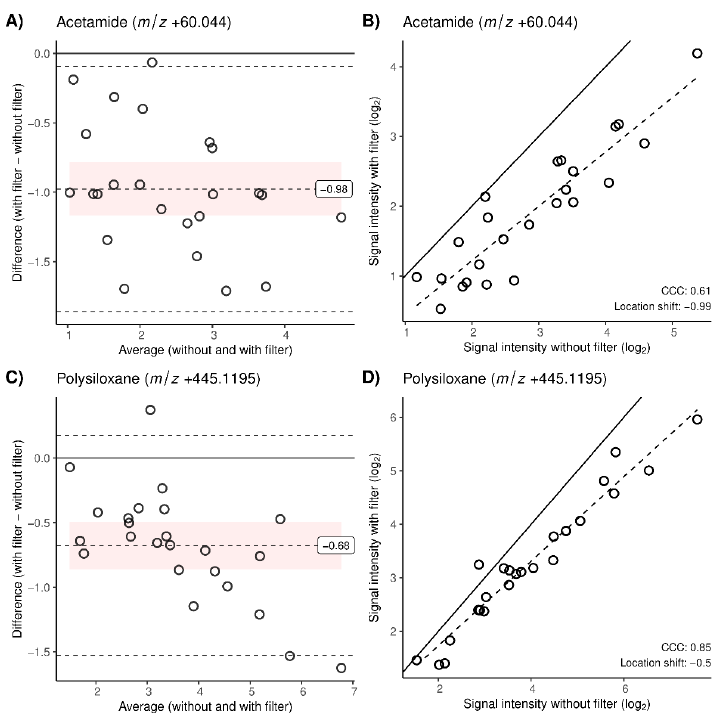
Figure 3. Same as in Figure 2, Bland – Altman and signal intensities of all pairs of measurements are presented for ( A , B ) acetamide ( m/z +60.044) and ( C , D ) polysiloxane ( m/z +445.1195), both contami- nants in positive ionization mode. Molecules 2023 , 27 , x FOR PEER REVIEW contaminants in positive ionization mode.